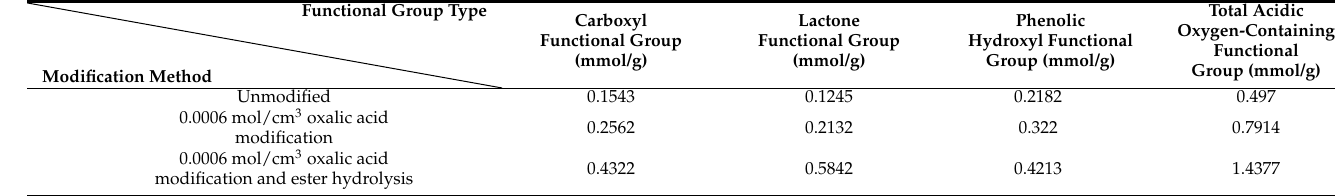
Table 1. Boehm titration test values of functional groups before and after activated carbon modification.